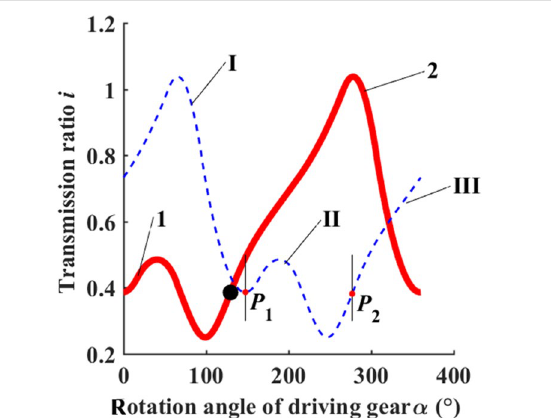
Figure 7 Divided and combined gear-ratio curves. I, II, III. Curve section of original transmission ratio; 1, 2. Curve section of new transmission